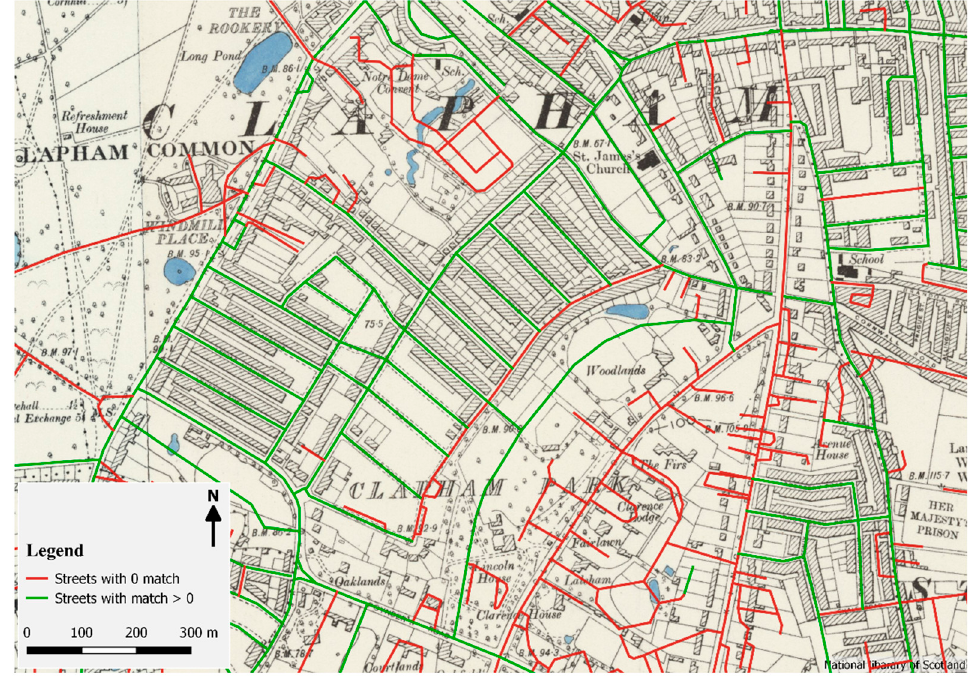
Figure 6. The street network of Clapham in 2016 overlaying a historical map from the early 1900s. (Source: Street network from the OS Open Road data; historical base map web service by the National Library of Scotland; historical map data from OS 1:1million–1:10K, the